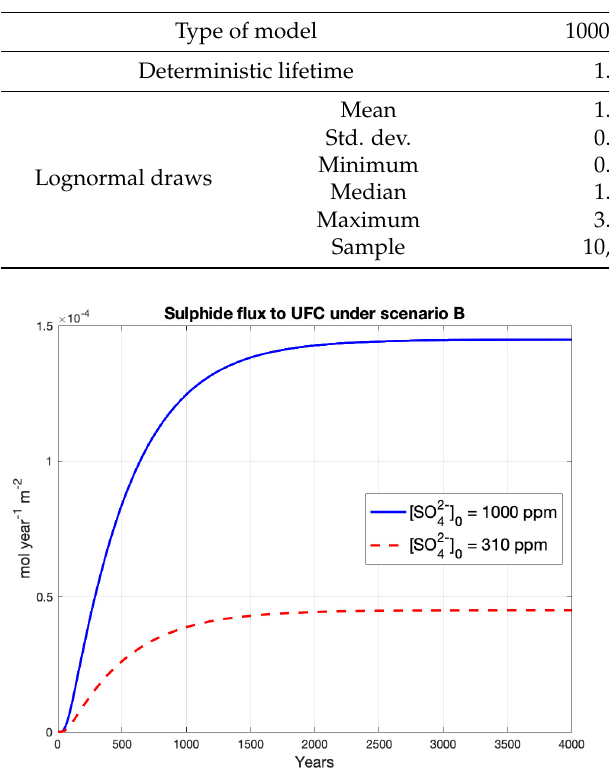
Figure 4. Sulphide concentration and flux to UFC under Scenario II.